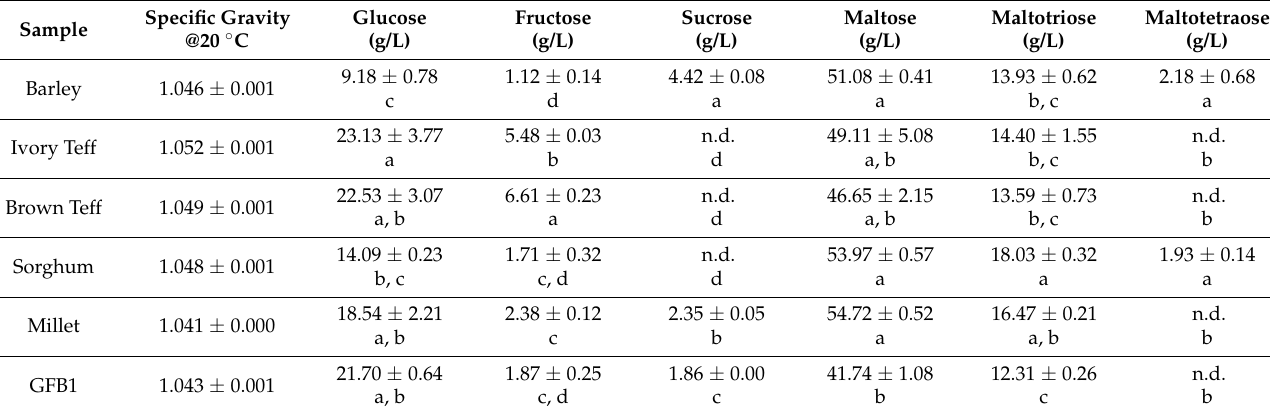
Table 3. Summary of specific gravity measurements and wort sugars in the ivory teff, brown teff, sorghum, millet, and GFB1 ExGM samples compared to